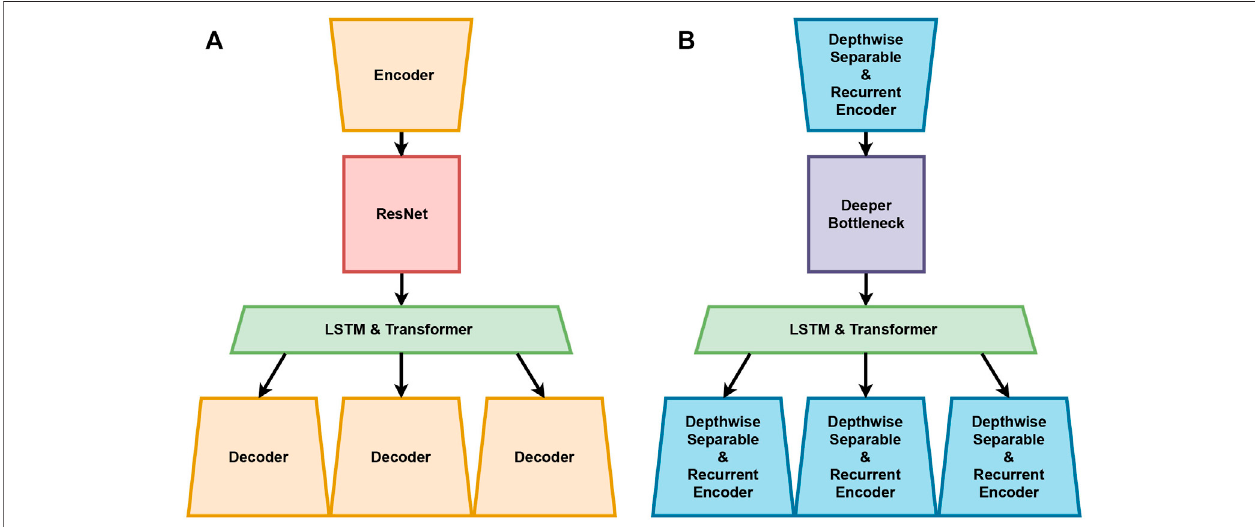
FIGURE2| Structure oftheEQTransformer. (A) EQTransformer isdividedintofour main parts: encoder, decoder,ResNet, and LSTM & transformer. (B) Structure of our LEQNet. LEQNet comprises four main parts: an encoder that uses the depthwise separable CNN with recurrent CNN, a decoder that uses the depthwise separable CNN with recurrent CNN, residual Bottleneck CNN, and LSTM & Transformer.